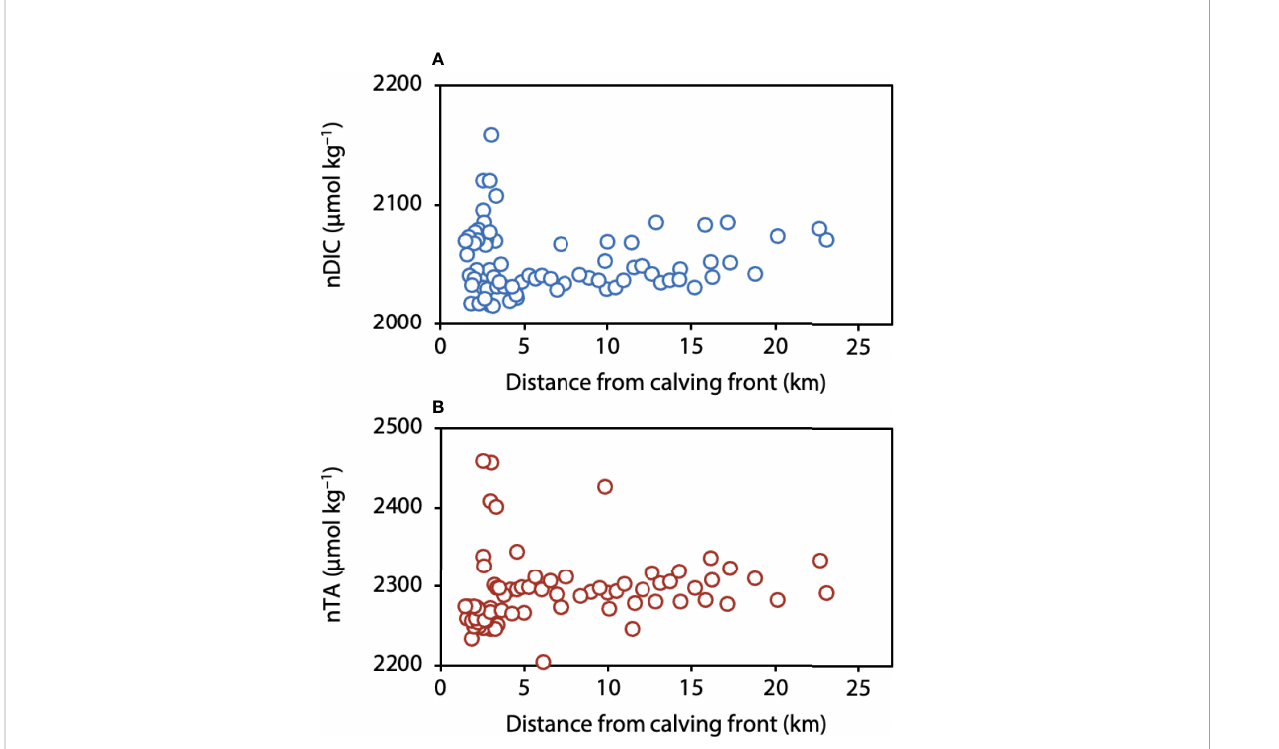
FIGURE 8 Distributions of (A) nDIC and (B) nTA in relation to the calving